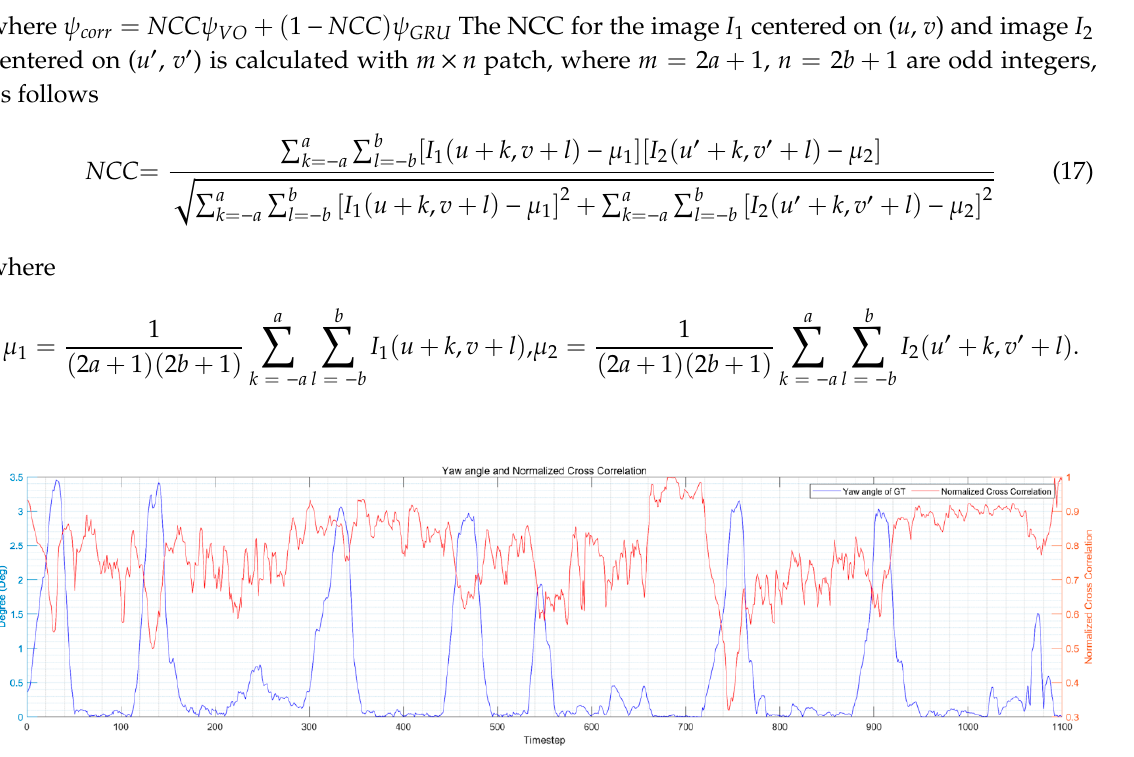
Figure 8. Camera yaw angle calculated by MVO and Normalized Cross-Correlation (NCC) of each pair of frames for the KITTI 07 sequence. The left vertical axis represents the yaw angle and the right vertical axis is the NCC.